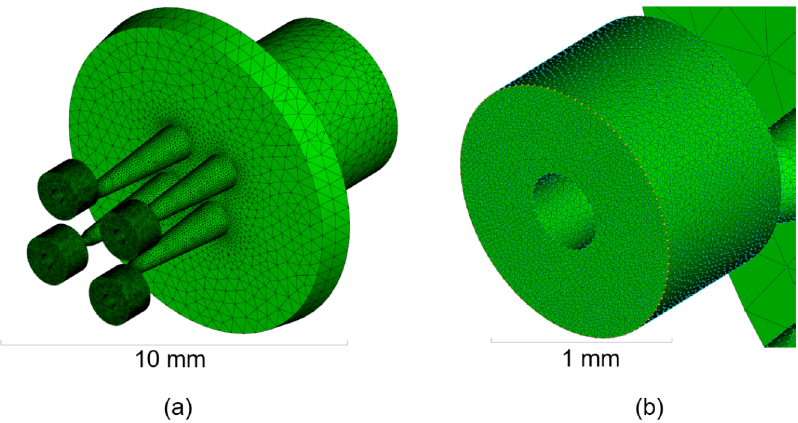
Table 3. Multi-scale meshing parameters for the single micro-plastic components.